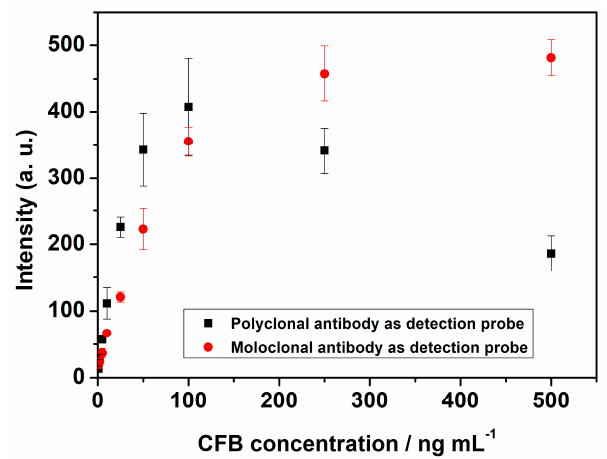
Figure 3. LFI performance comparison of monoclonal or polyclonal antibody as detection antibody.